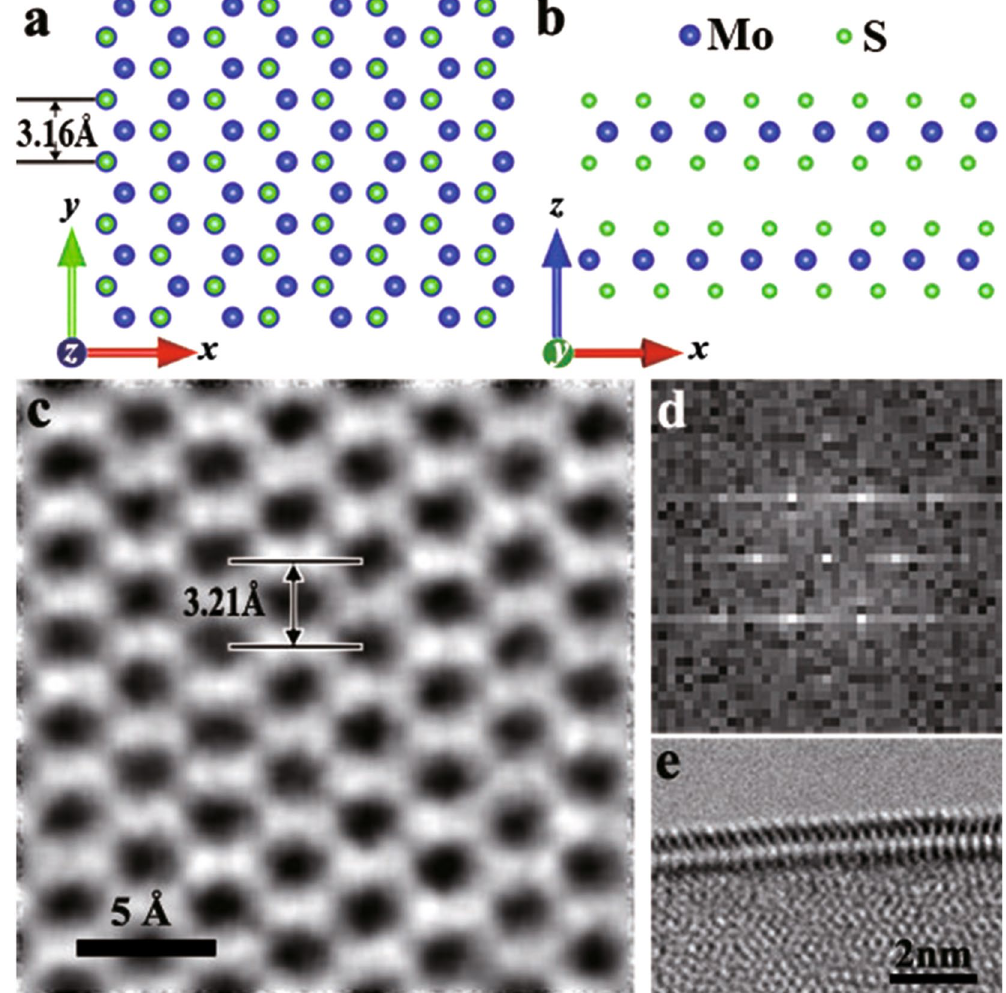
Figure 1. Atomic structure of bilayer MoS 2 with the standard AB stacking and without any RSFs. ( a,b ) Top and side views of the atomic model of the AB-stacked bilayer MoS 2 . ( c,d ) HRTEM image and its FFT pattern of an AB-stacked bilayer MoS 2 sheet. This HRTEM image is low-pass filtered and no artifacts are caused by the filtering, which has been widely used to remove noise in HRTEM images 23–32 (see the unprocessed HRTEM image and more details in Supplementary Fig. S1). The inner six spots adjacent to the center in ( d ) are ¯ {1100} , whereas the outer six spots are ¯ {1210} . ( e ) TEM image of a folded edge of the MoS 2 sheet. This edge is far away from the area in ( c